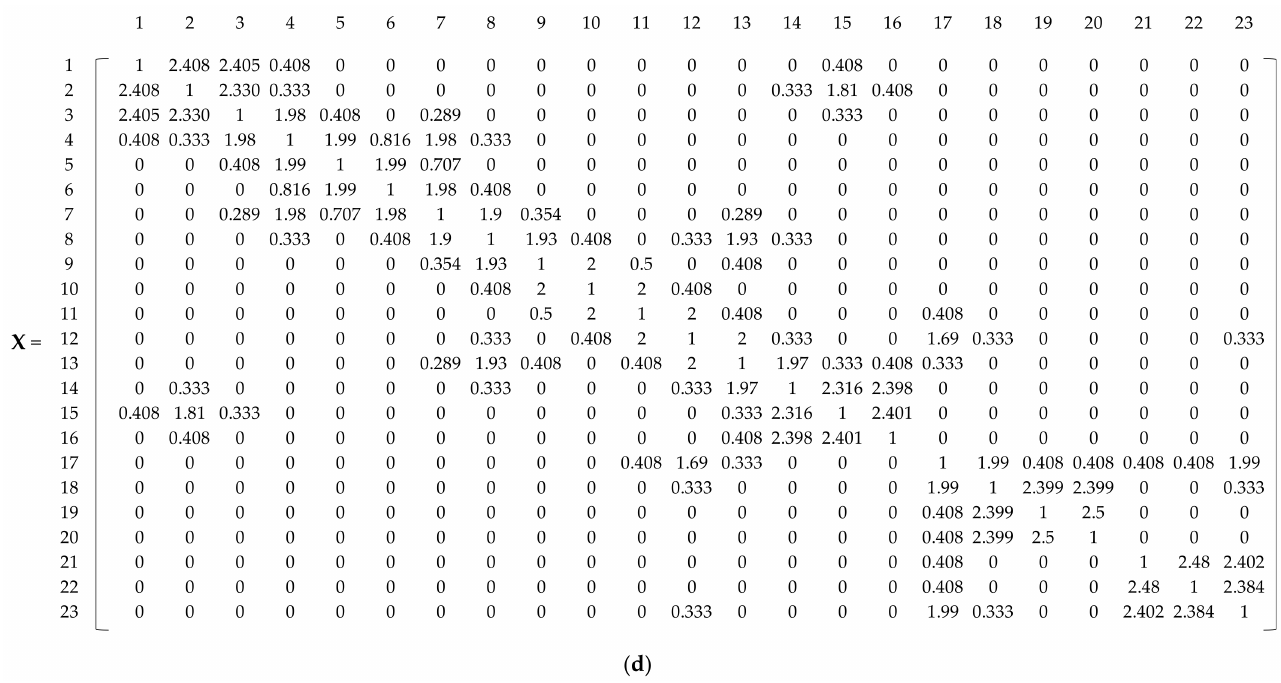
Figure 5. Construction of attribute matrices for the sample network. ( a ) Adjacency matrix ( A ) obtained from Equation (1); ( b ) TS matrix obtained from Equation (3); ( c ) HS matrix obtained from Equation (4); ( d ) Input matrix ( X ) for training the SOM obtained from Equation